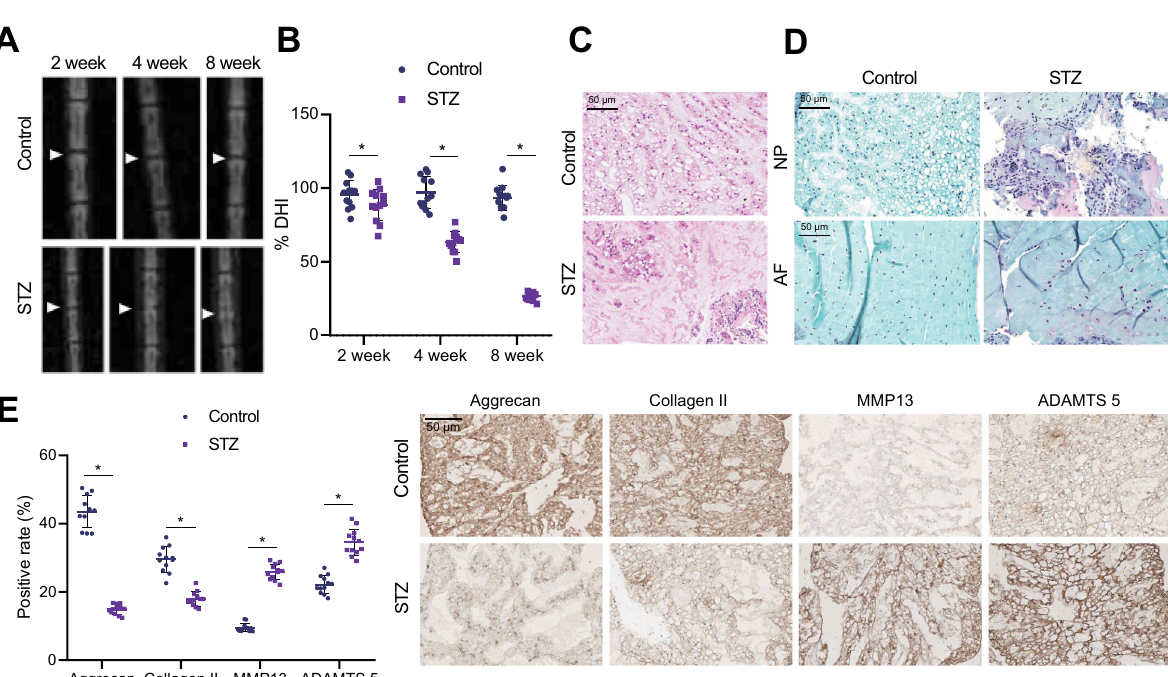
Fig. 1 IDD occurs in STZ‑induced T1DM rats. A Representative X‑ray images of IVDs of normal and STZ‑induced T1DM rats. B DHI measurement of normal and STZ‑induced T1DM rats. C HE staining of NP tissues. NP: nucleus pulposus. D Safranin O‑fast green staining for NP tissues and AF tissues. AF: annulus fibrosus. E IHC analysis of ECM‑related gene expression in rat NP tissues. n mean standard deviation. Data between two groups were compared by unpaired t ‑test ±